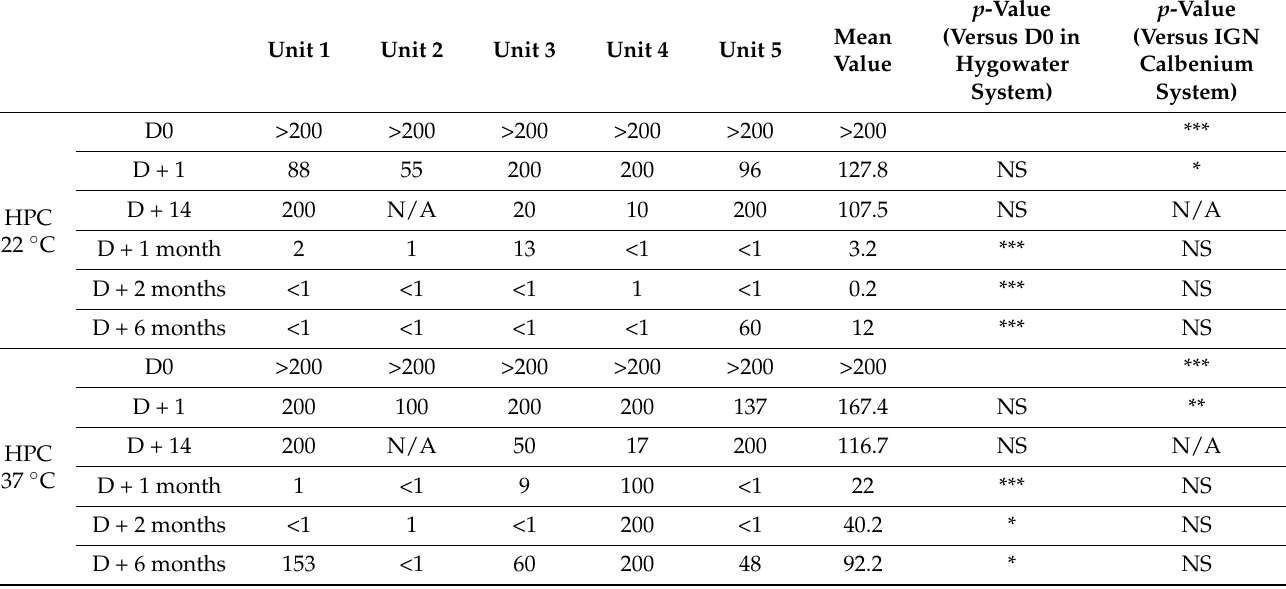
Table 4. Sample results (in cfu/mL) and statistical